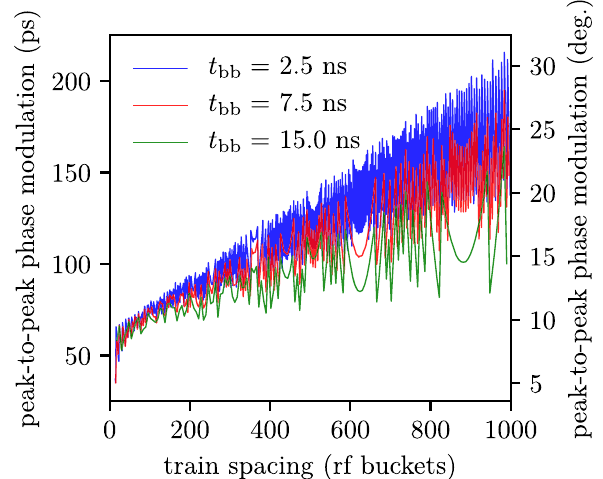
the cavity voltage from Eq. (26) on the train spacings for different bunch